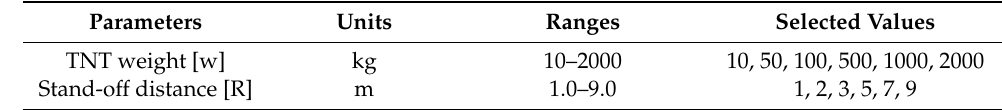
Table 3. Blast load parameters used in the analysis and their ranges [2].